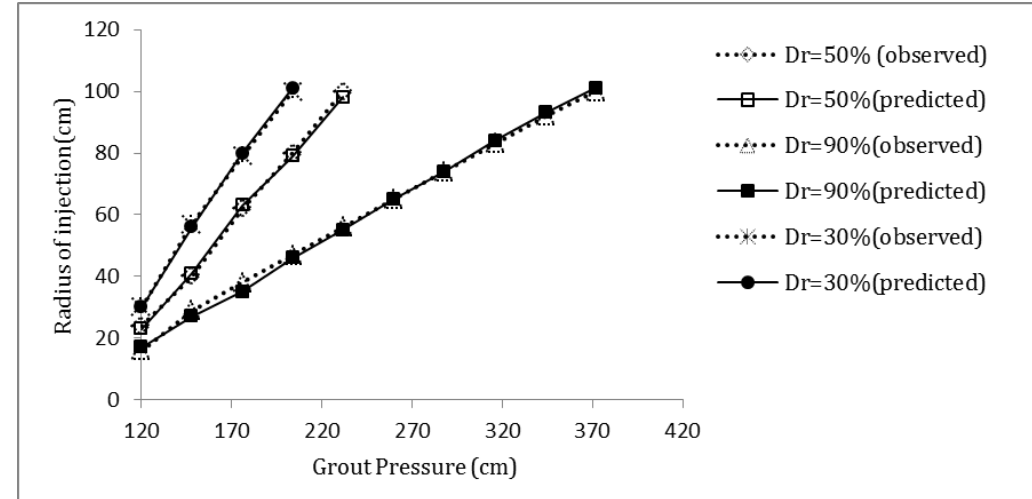
Fig. 6. Effect of soil relative density on the radius of slurry injection based on experimental tests and ANN predictions (medium soil and W/S=0.33).